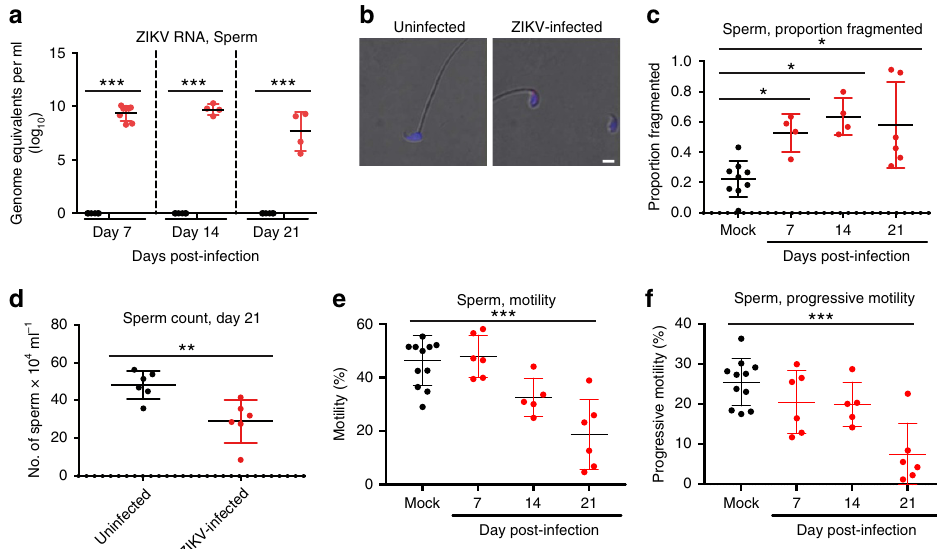
Figure 2 | ZIKV infection of the sperm. Ten- to eleven-week-old male Ifnar1 (cid:2) / (cid:2) mice were inoculated with 5 (cid:3) 10 5 p.f.u of ZIKV strain PRVABC59 by a subcutaneous route (s.c.) into each hind leg (1 (cid:3) 10 6 p.f.u. total) and compared to age-matched PBS mock-infected mice. Sperm form the caudal epididymis was collected immediately after euthanization. ( a ) ZIKV RNA copies in the caudal sperm of mice measured by qRT-PCR ( n ¼ 4 or greater). Results are expressed as genome equivalents per ml. The horizontal hatched line indicates the limit of detection ( o 100 copies per ml). ( b ) Immunofluorescence analysis of caudal sperm with anti-ZIKV antibody. Blue indicates DAPI staining and red represents ZIKV. ( c ) The proportion of fragmented sperm was assessed following staining with Diff-Quick solution. ( d – f ) Fertility parameters of caudal sperm were evaluated, including ( d ) concentration on day 21 after infection and ( e ) the percentage motility and ( f ) progressive motility at the indicated times post-infection. Scale bars, 2 m m in b . The data shown are from one experiment that is representative of the same outcome in the two studies performed. Bars indicate mean values and error bars indicate s.d. Statistical differences are given ( a , two-way ANOVA followed by the Bonferroni post-test; ( c , e , f ) one-way ANOVA followed by Dunnett’s test; d , Mann–Whitney